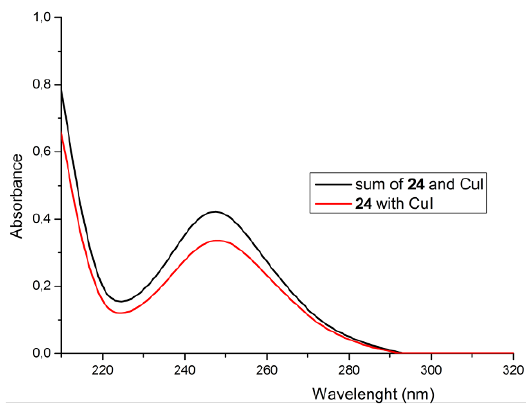
Figure 3. The sum of the UV spectra of 24 and CuI (black) and UV spectra of copper(I) complex of 24